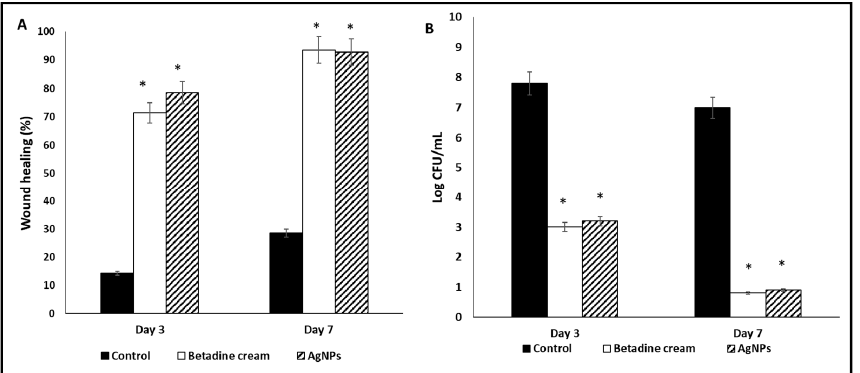
Figure 12. Characters of the wounds on days 3 and 7: ( A ) wound healing percentage and ( B ) log CFU/mL. The symbol (*) represents a significant change ( p < 0.05) in comparison with the control group.